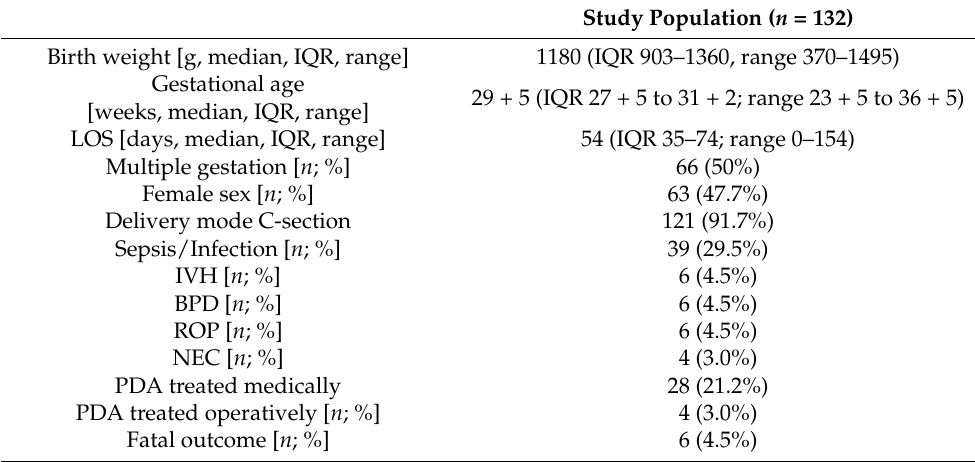
Table 1. Demographic and clinical characteristics of the study population sample.